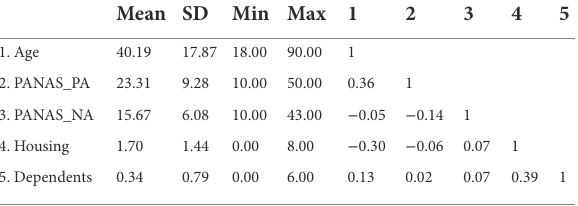
TABLE 2 Independent variable summary statistics (full